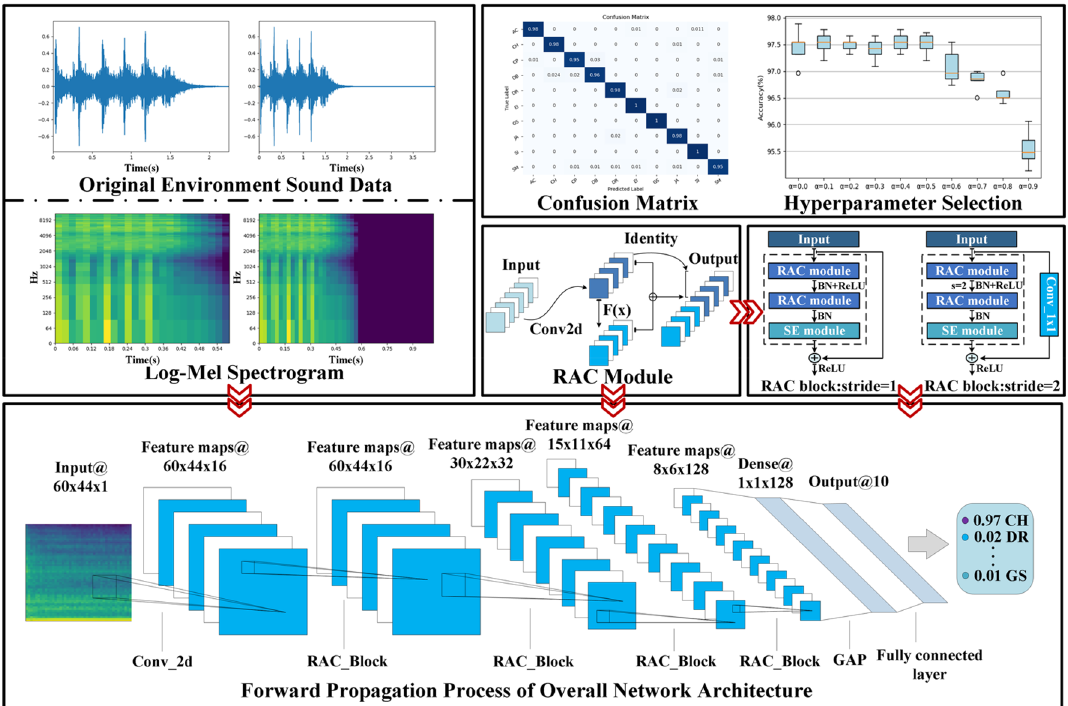
Figure 1. The specific process of ESC using RACNN. (Heat maps are drawn with the audio processing library Librosa 0.8.1. Detailed descriptions are available at https:// libro sa. org/ doc/ latest/ index.